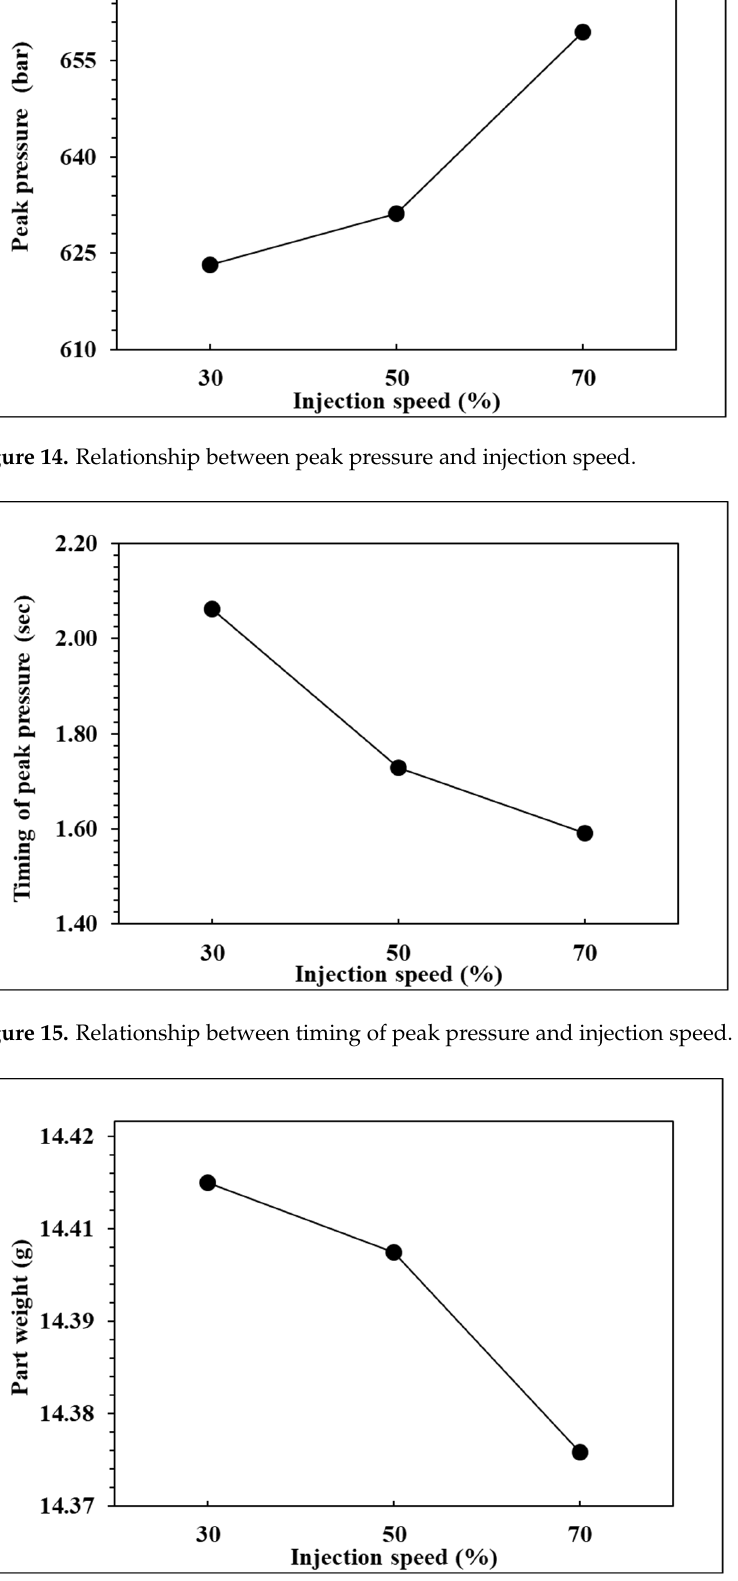
Figure 16. Relationship between part weight and injection speed.